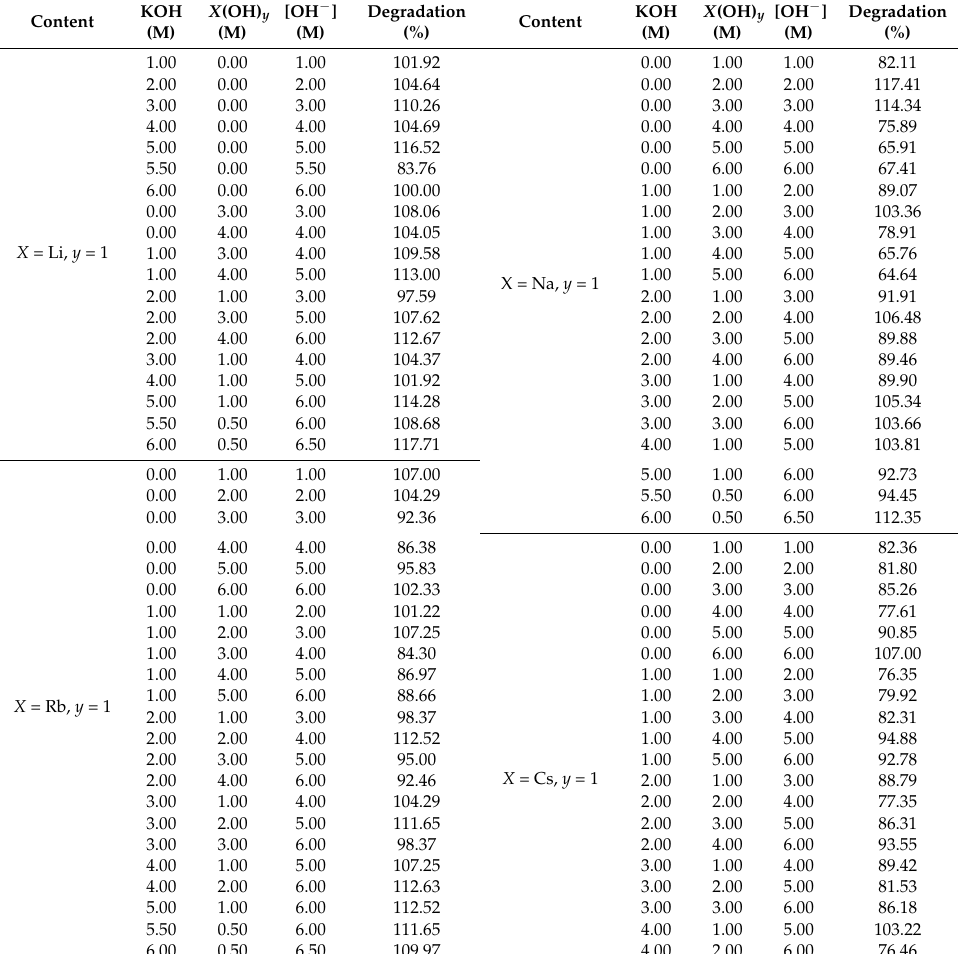
Table A2. Room temperature degradation performances (defined as percentage capacity loss per cycle) of electrolytes with various concentrations of KOH and other hydroxides normalized to that of 6 M KOH aqueous solution. Electrolyte with degradation value higher than 100% implies that it is more corrosive compared to the standard electrolyte (6 M KOH aqueous